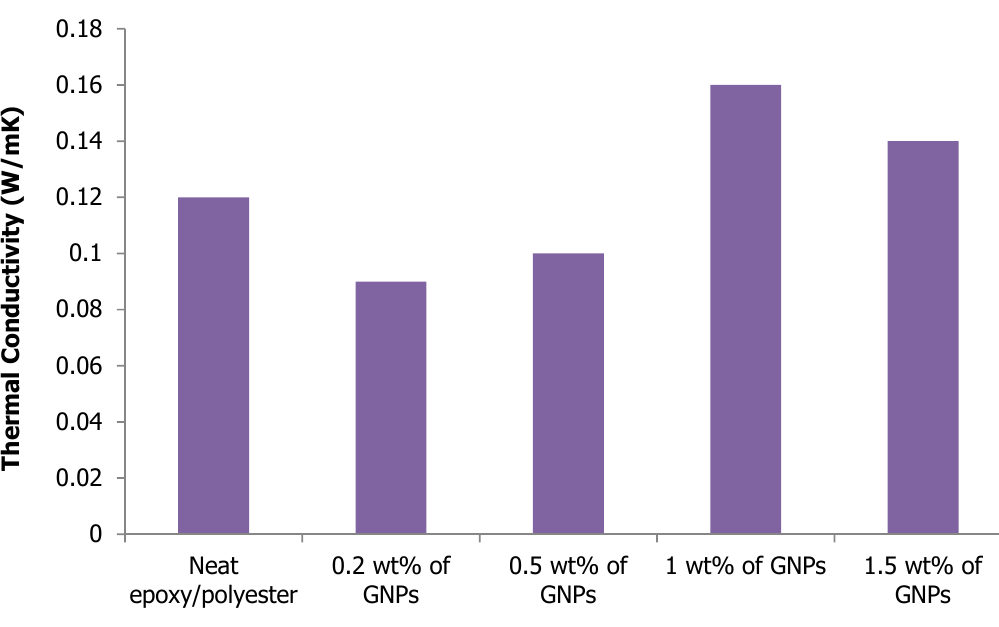
Figure 7. Thermal conductivity of nanocomposites.